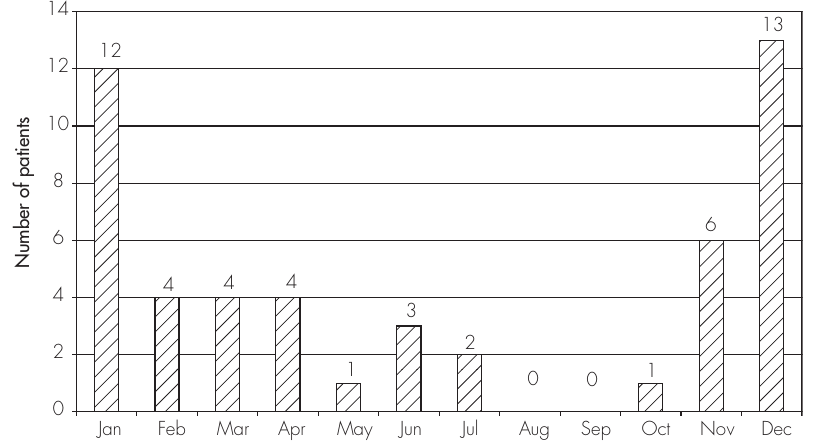
Fig. 2. – Monthly distribution of trichinellosis in a series of 50 hospitalized patients in Belgrade